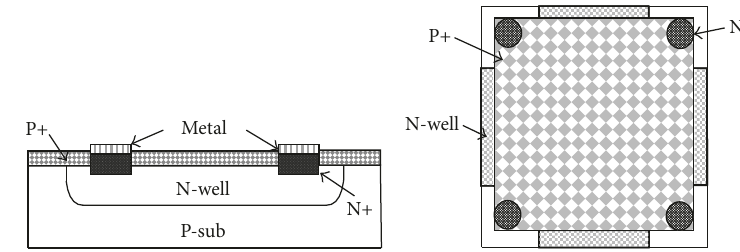
Figure 1: Cross-sectional view and top view of the Hall element.